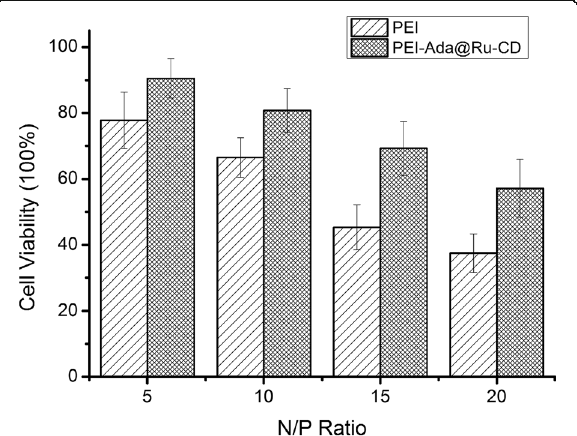
Fig. 6 Cell viability of PEI/DNA and PEI-Ada@Ru-CD/DNA complexes at various N/P ratios in A549 cell